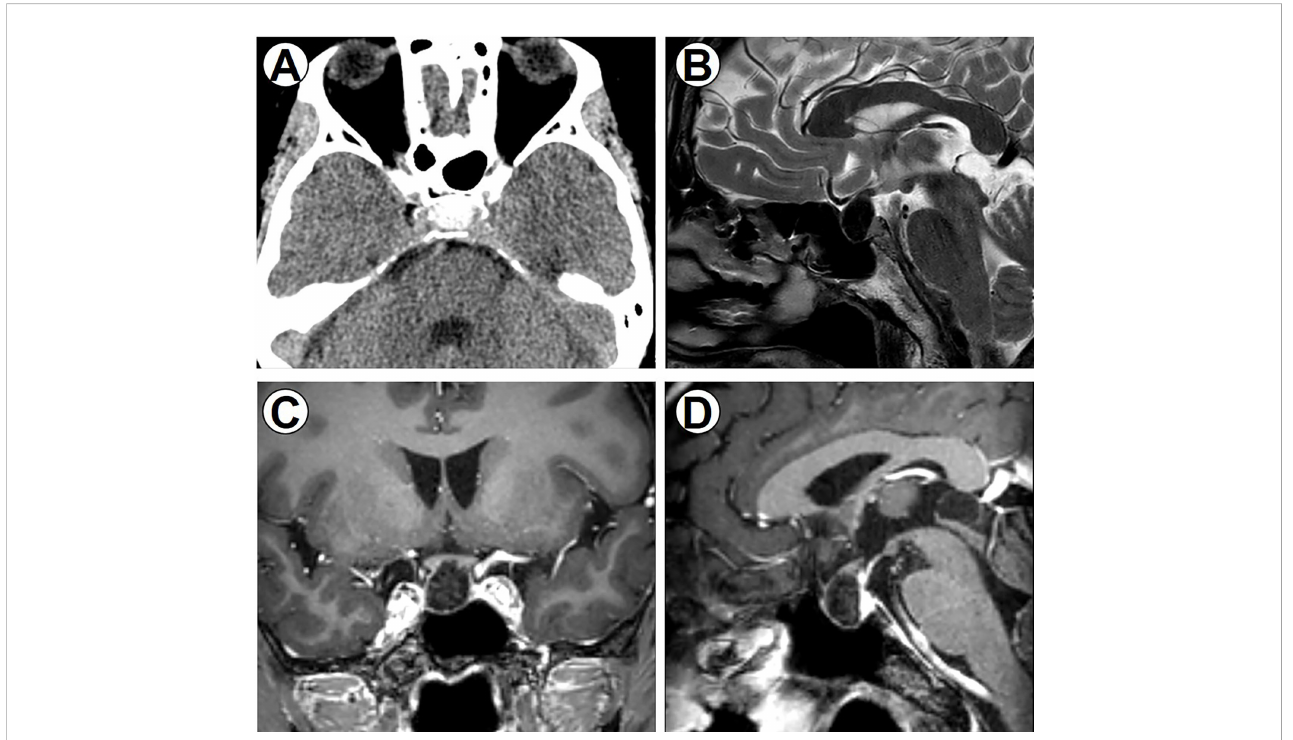
FIGURE 1 Perioperative imaging data. (A) Preoperative CT scan of the brain, axial section showing a sellar tumor with obvious calci fi cation. (B) T2-weighted sagittal image showing hypointense sellar lesion. (C) Coronal T1-weighted image. (D) Sagittal T1-weighted image with gadolinium contrast showing hypointense sellar lesion anterior to the pituitary gland without